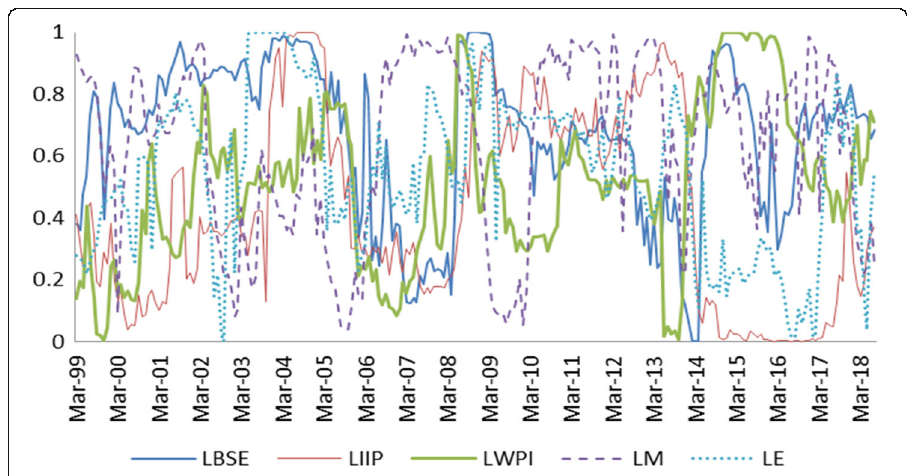
Fig. 5 Rolling Unit Root Test for original variables